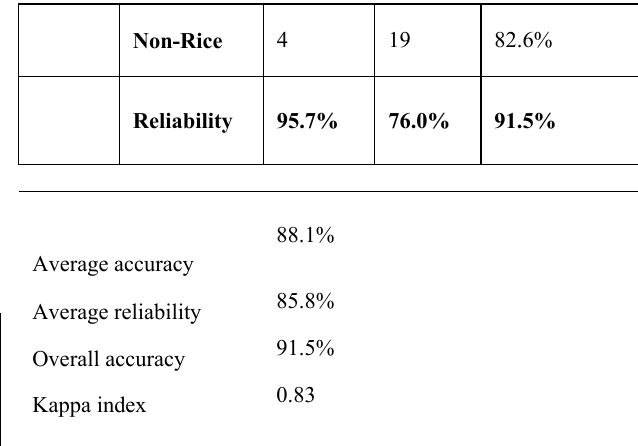
Table.8 Confusion matrix for accuracy assessment of rice classification for Integrated VV-VH